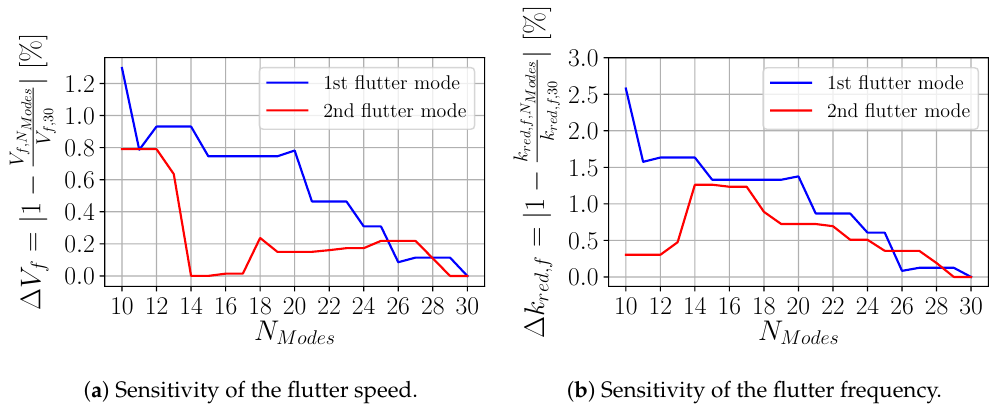
Figure 20. Sensitivity of the flutter limits with regard to the number of considered